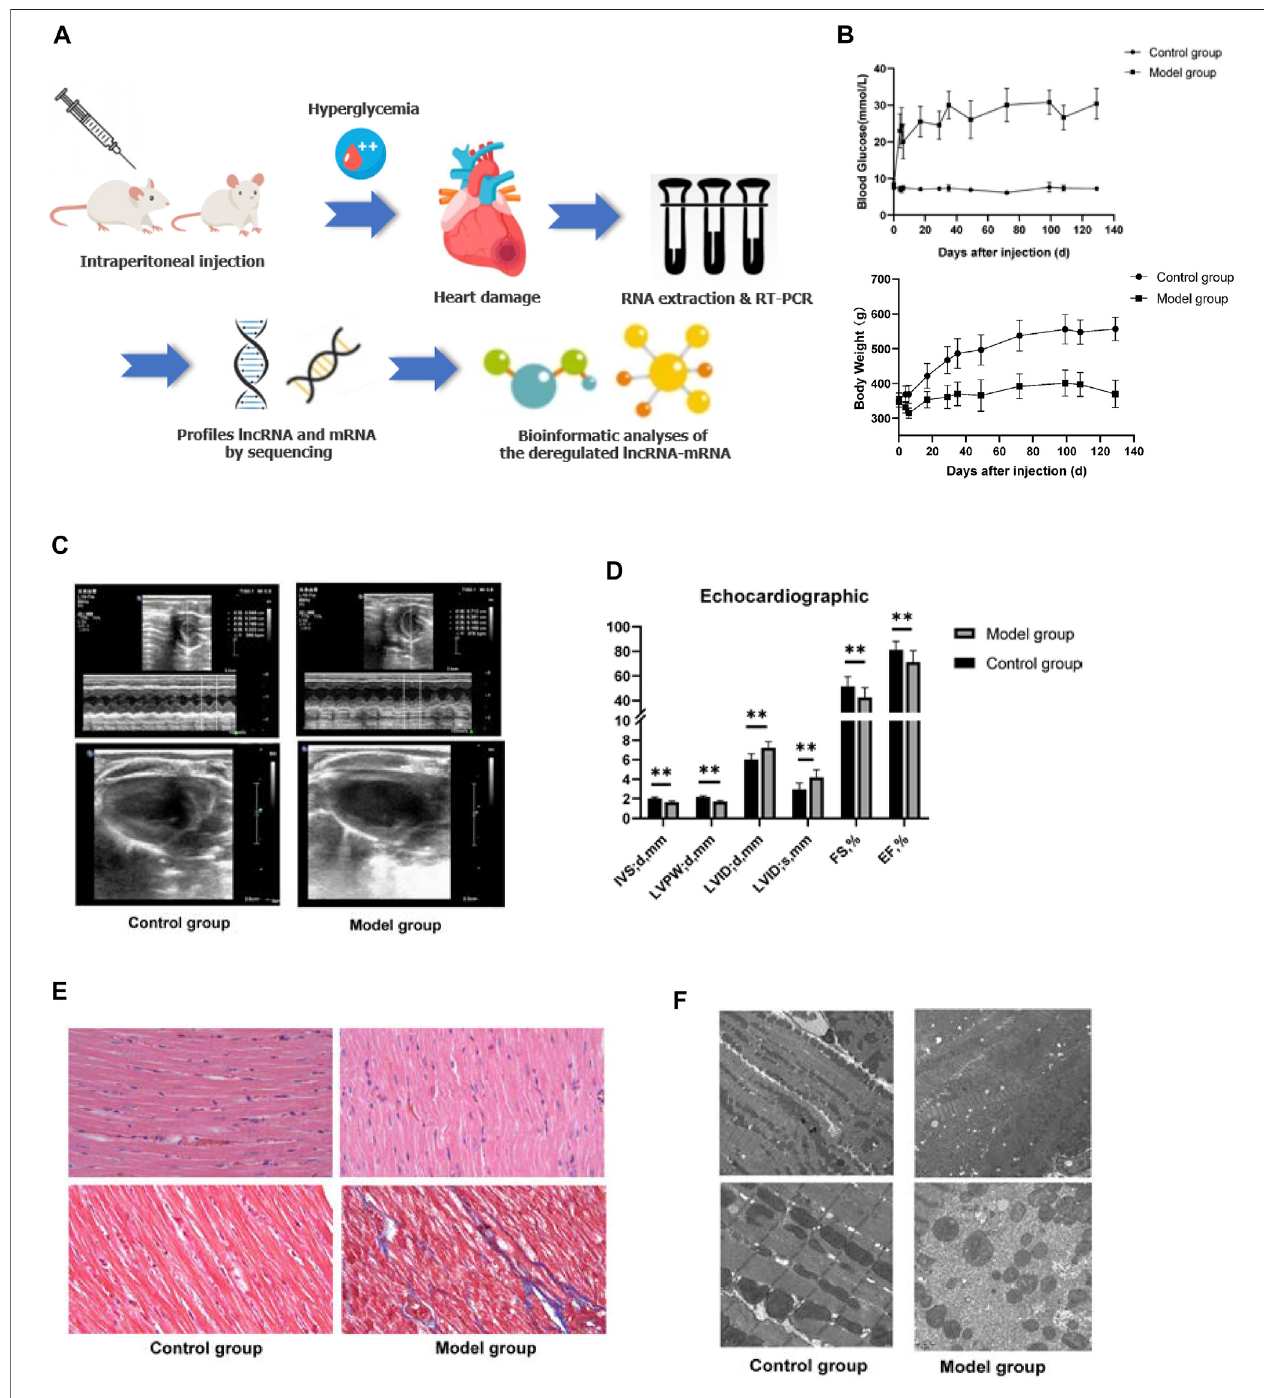
FIGURE 1 | General characteristics of the animal model. (A) Schematic depiction of the experimental design. (B) Blood glucose and body weight of the animals in thetwogroupsafterSTZinjection. (C , D) Echocardiographyoftheanimalmodel.Leftventricleinternaldimensionatend-diastole(LVID;d),leftventricleinternaldimension at end-systole (LVID;s), ejection fraction (EF), fractional shortening (FS), left ventricle posterior wall thickness at end-diastole (LVPW;d), interventricular septum thickness at end-diastole (IVS;d). Data are represented as mean ± SEM, ** p < 0.05. (E) HE (upper part), and Masson ’ s (lower part) staining. Masson ’ s staining identi fi ed massive fi brosis in the diabetic myocardium. (F) Transmission electron microscopy observed that cardiomyocytes in diabetic hearts appear damaged with loss of sarcomeres and pathological changes in the mitochondrial shape involving loss or reorientation of cristae and matrix depletion.